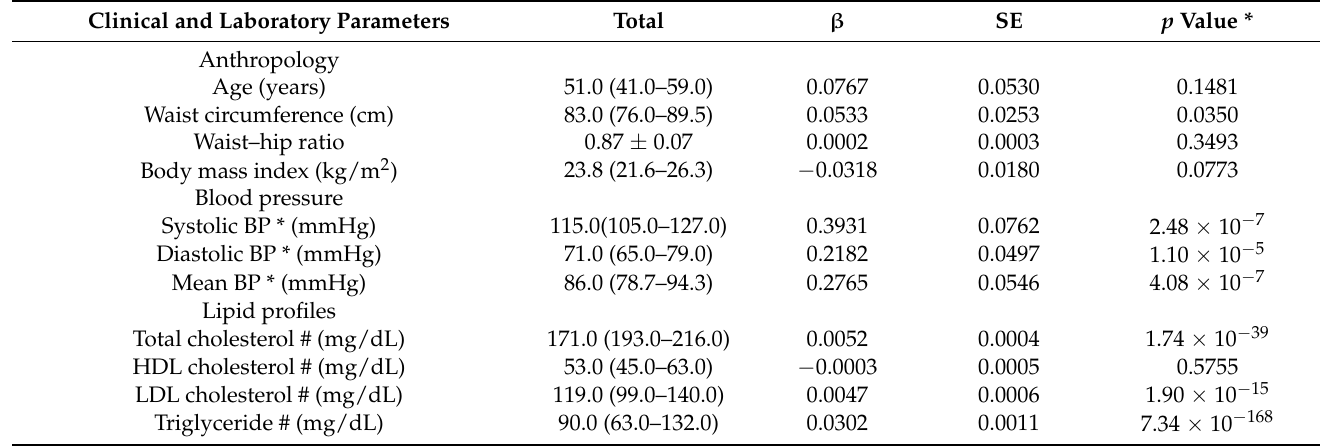
Table 1. Association of the rs1260326 genotypes with metabolic and hematological phenotypes. Clinical and Laboratory